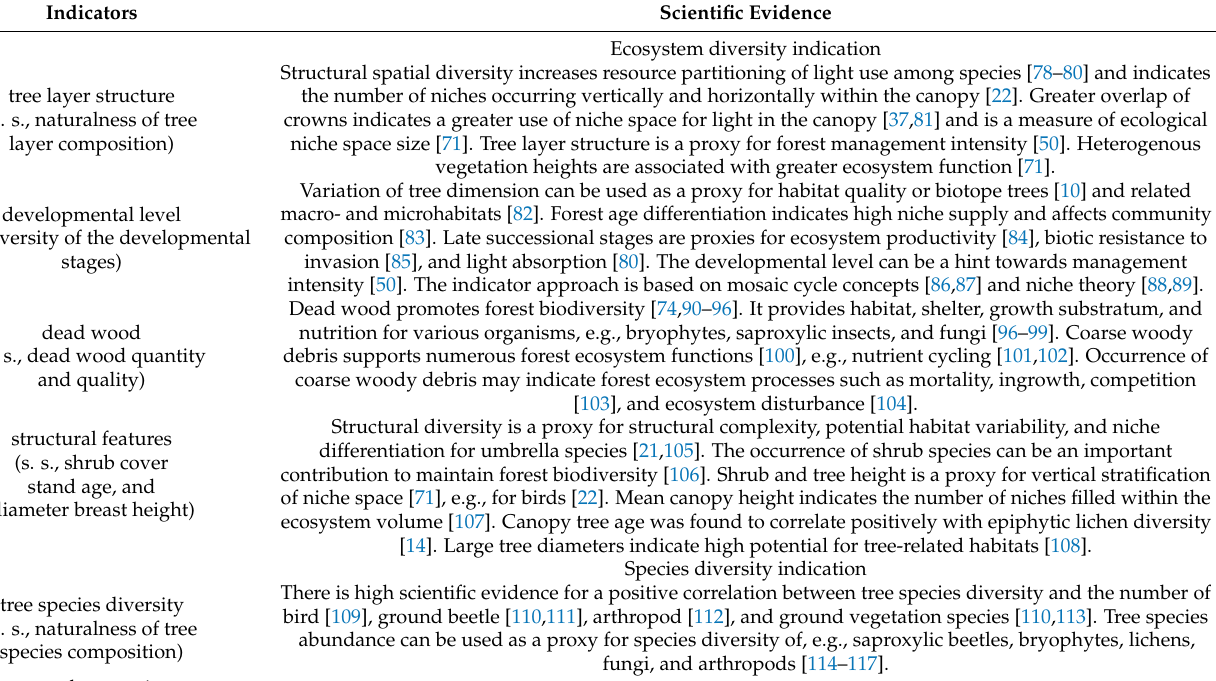
Table A2. Indicative value of diversity indicators. Surrogates for forest biodiversity and scientific evidence for their indicative